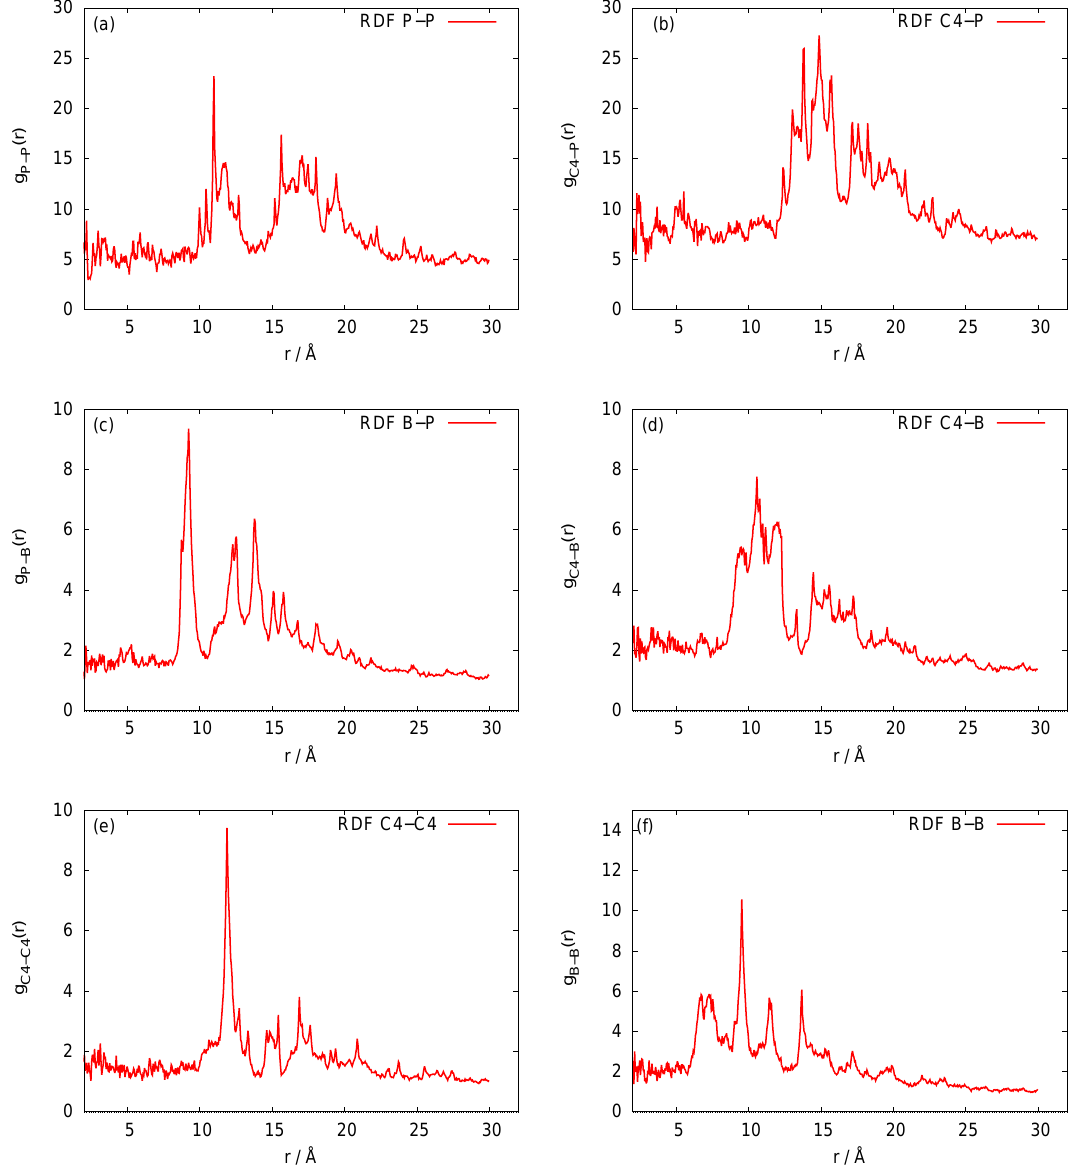
Figure 3. Behaviors of the radial distribution functions for the 10-ring RNA nanotube modelled with coarse-grained approximations. ( a – f ) present the following characteristics of this RNA nanotube: the radial distribution functions for P-P, C4-P, B-P, C4-B, C4-C4, and B-B atoms,